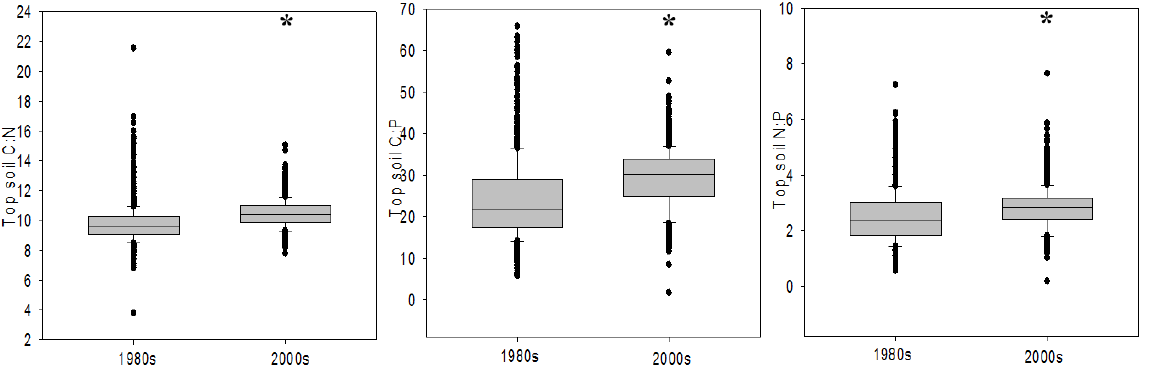
Figure 3. The vertical box plot of topsoil C:N, C:P, and N:P ratios in 1980s and 2000s, respectively, in Taihu Lake basin. The boundary of the box closest to zero indicated the 25th percentile, a solid line within the box marked the median, and the boundary of the box farthest from zero indicated the 75th percentile. Whiskers (error bars) above and below the box indicated the 90th and 10th percentiles. “*” indicates the difference was significant at 5% level.